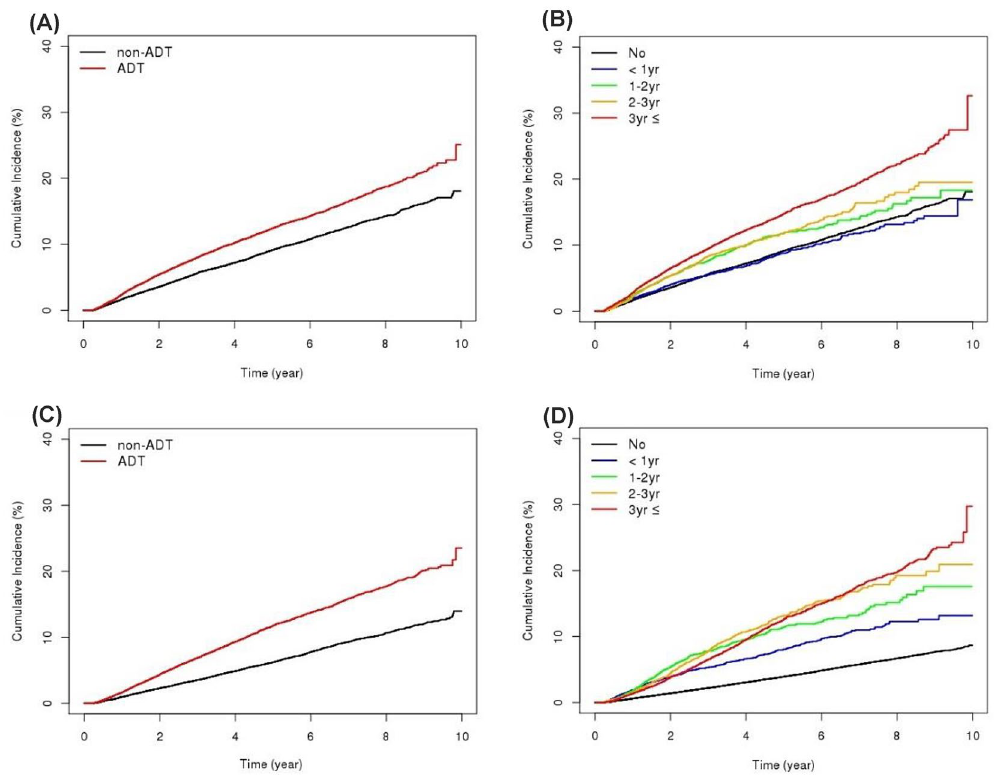
Figure 2. Cumulative incidences of osteoporosis and fractures in the matched cohort. ( A ) Incidence of osteoporosis according to the use of ADT. ( B ) Incidence of osteoporosis according to the duration of ADT use. ( C ) Incidence of fractures according to the use of ADT. ( D ) Fractures according to the duration of ADT use. ADT androgen deprivation